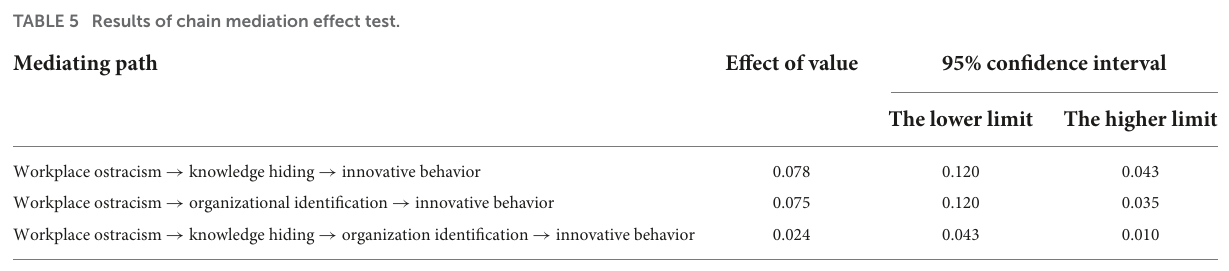
TABLE 5 Results of chain mediation effect